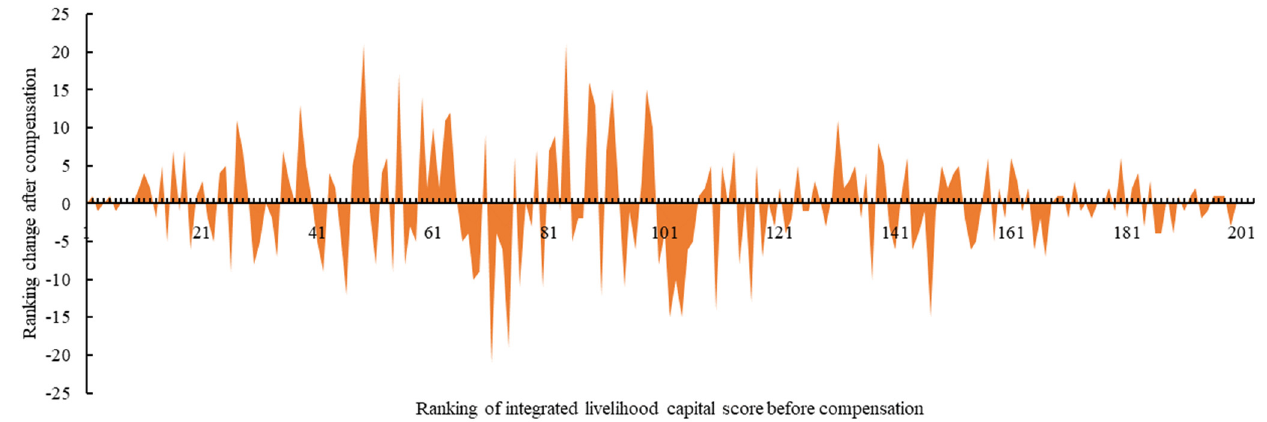
Figure 4. Changes in the ranking of integrated livelihood capital scores households before and after compensation.